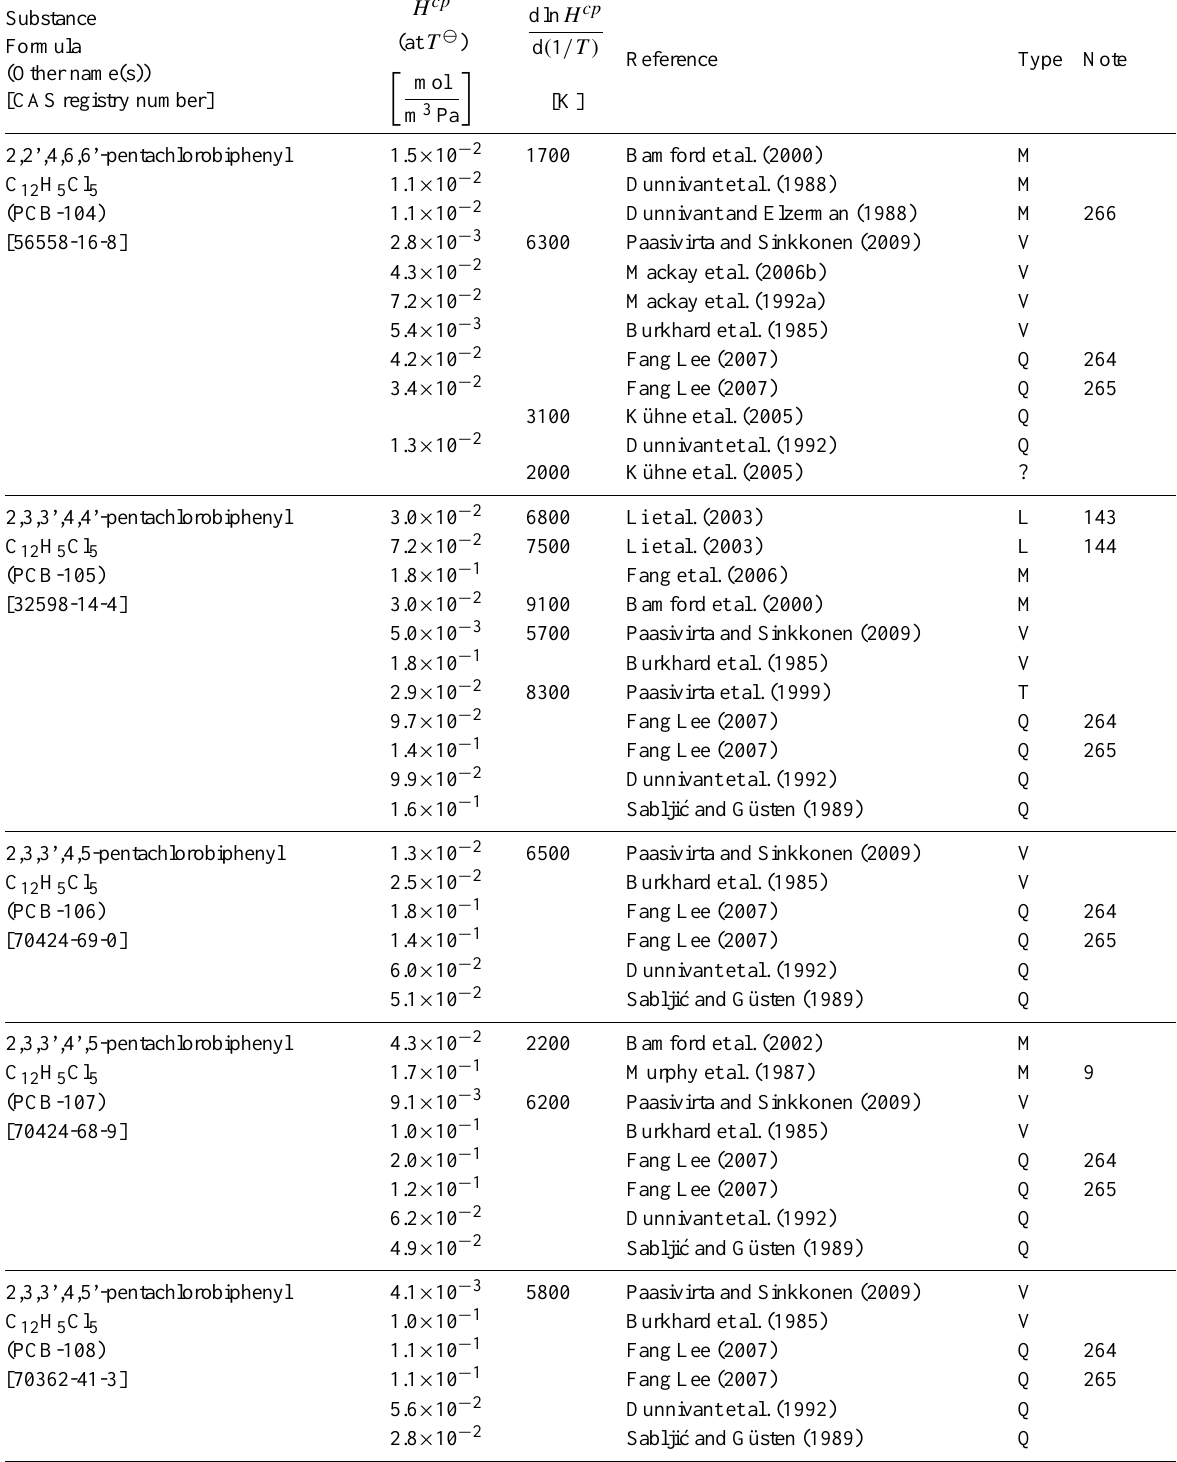
Table 6: Henry’s law constants for water as solvent